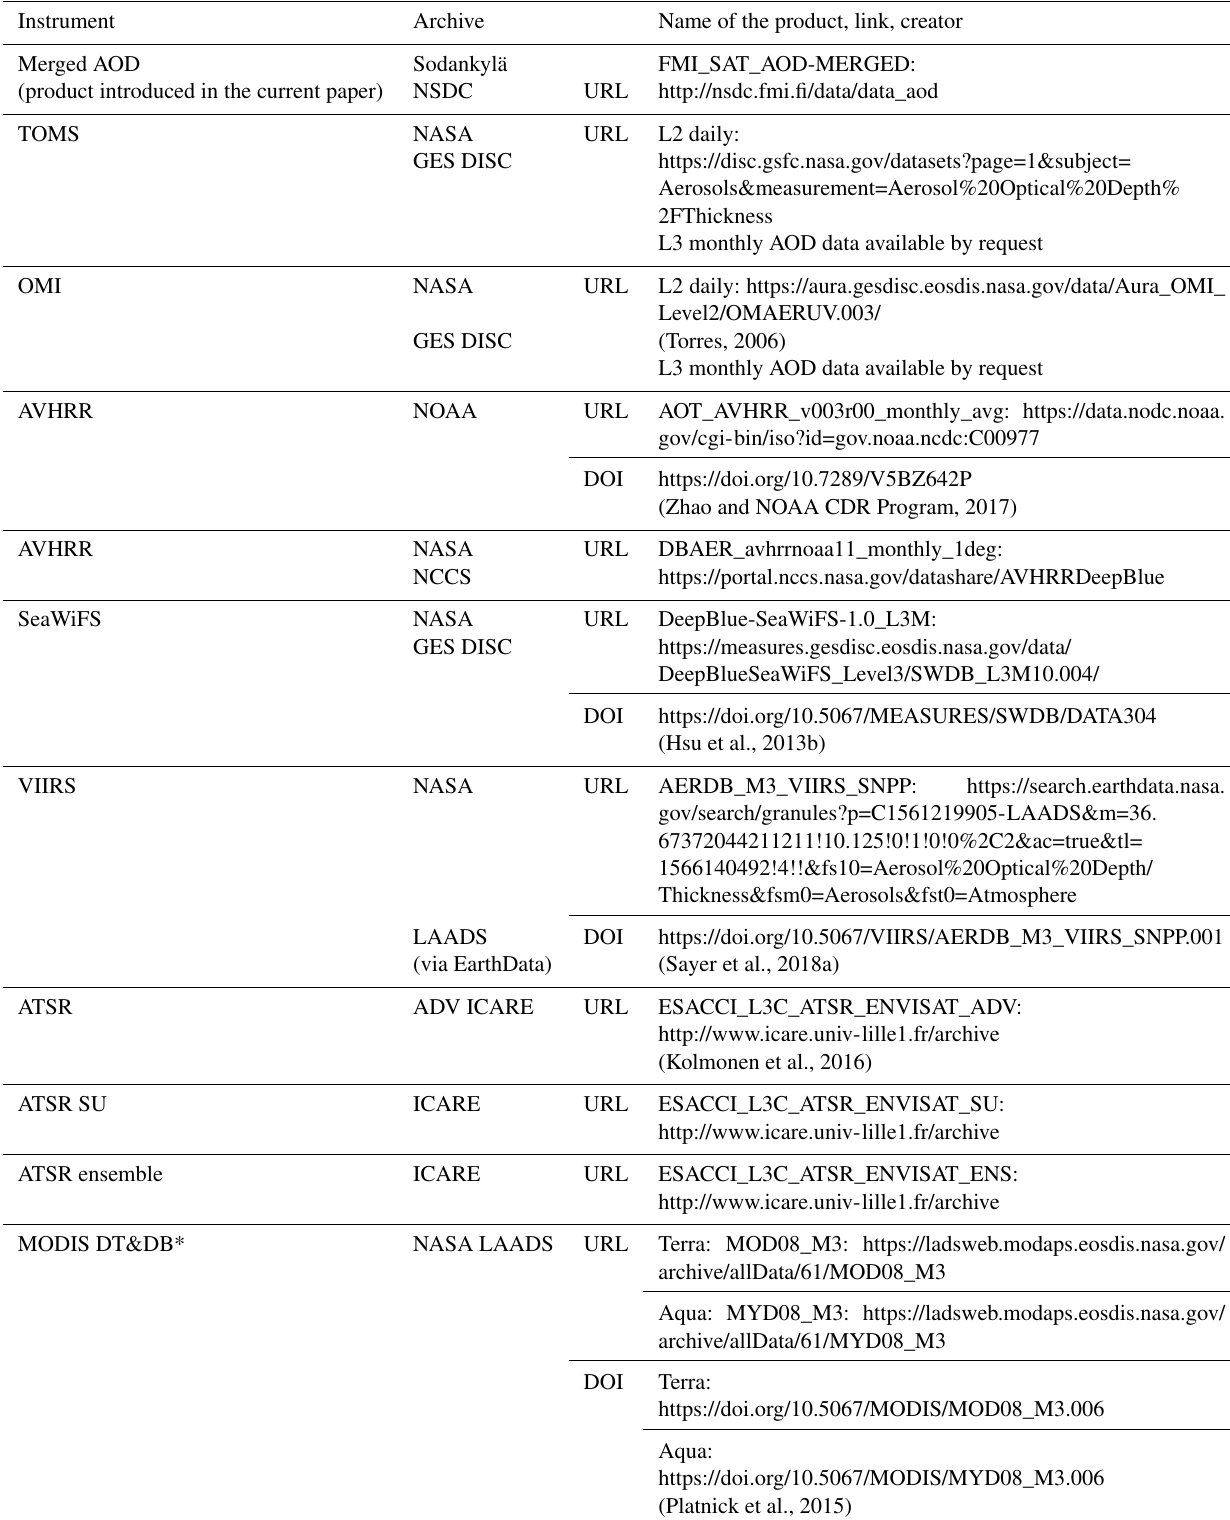
Table 4. Instrument, archive, URL and DOI (last access: 17 February 2020, for all), name and creator of the products used in the current study (if